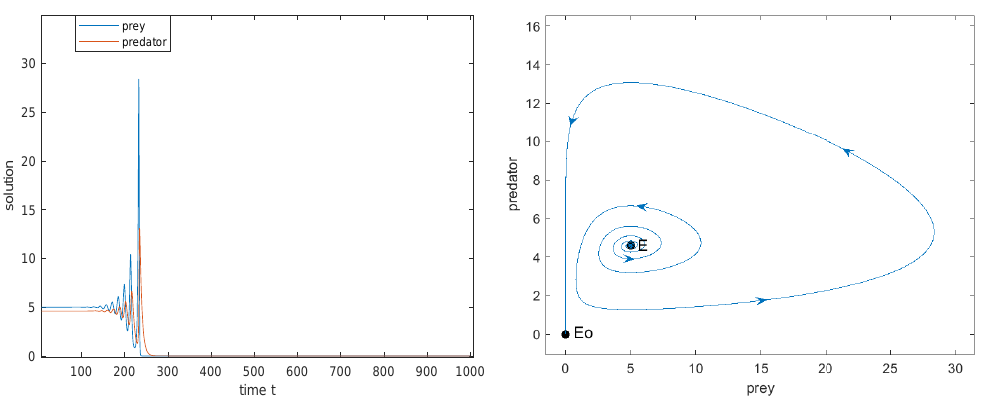
Figure 12. τ = 16 ∈ ( τ + , ∞ ) = ( 14.6586, ∞ ) , E in is unstable. Initial value: ( φ 1 , φ 2 ) = ( 5,4.598 ) 1